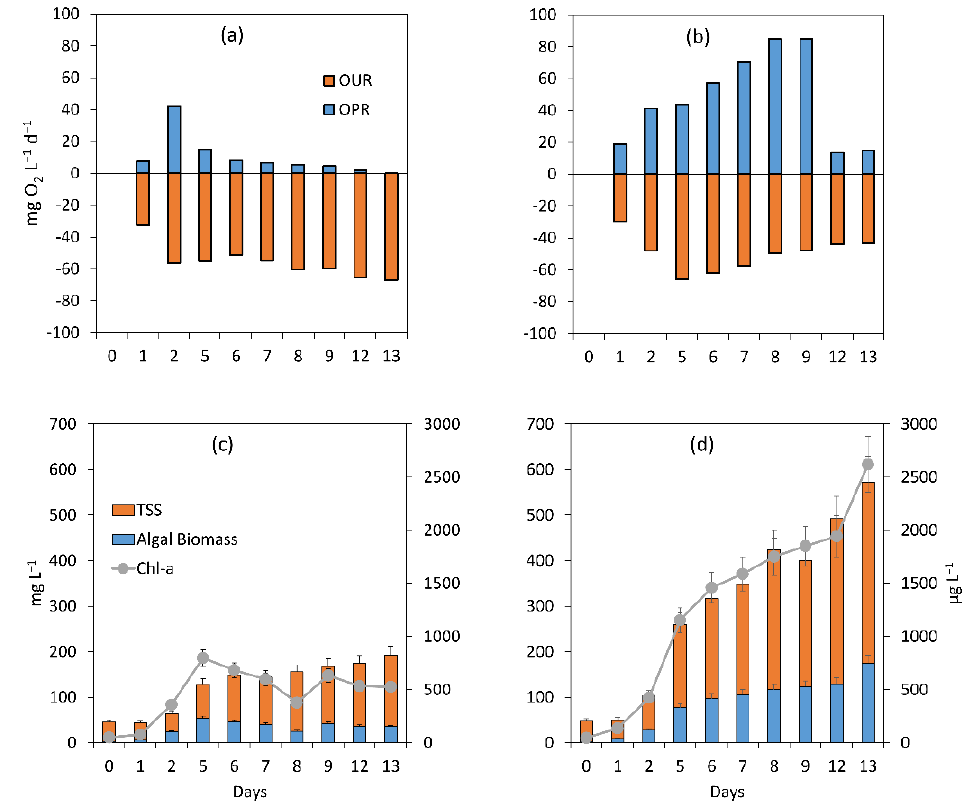
Figure 7. Daily OUR and OPR ( a ) HL.X10.N, ( b ) HL.X10.P and biomass evolution ( c ) HL.X10.N, ( d ) HL.X10.P including TSS, microalgal biomass (mg L − 1 ) and Chl-a ( µ g L − 1 ) under the impacts of extreme N:P ratios.